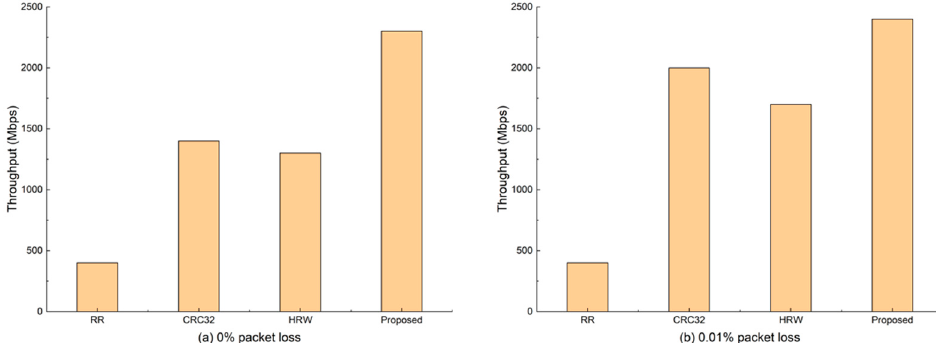
Figure 3. Throughput for different packet loss rates.